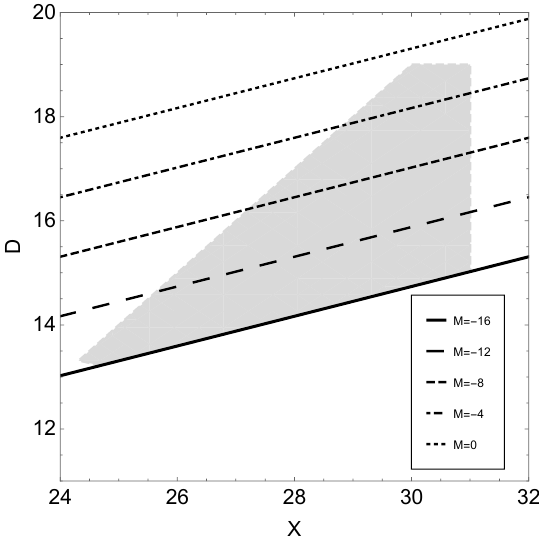
Figure 10. Parameter space of x B , T D , M by X = log ( x b ) , D = log ( ¯ T D ) and M = log ( ¯ M